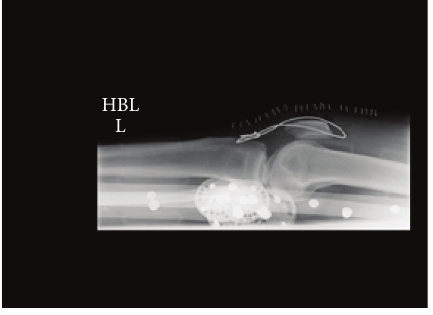
Figure 4: Postoperative left knee